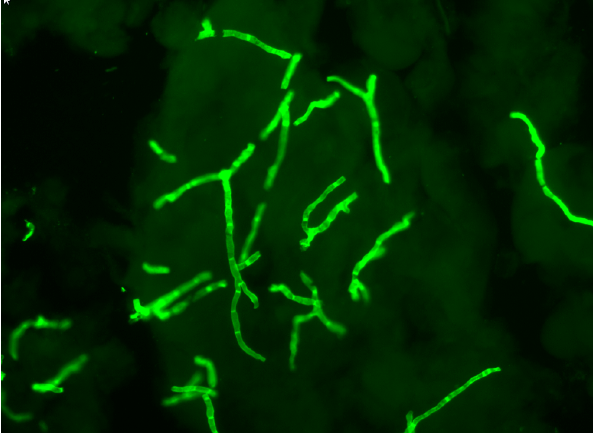
Figure 1. Direct mycological examinations using fluorescence microscopy showing hyphae in an infected nail. Bar: 20 μ m